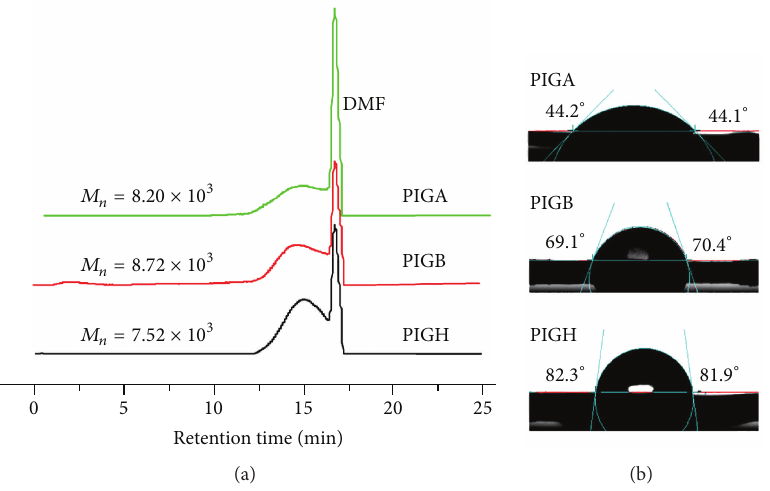
Figure 4: GPC curves (a) and contact angles (b) of PIGA, PIGB, and PIGH.